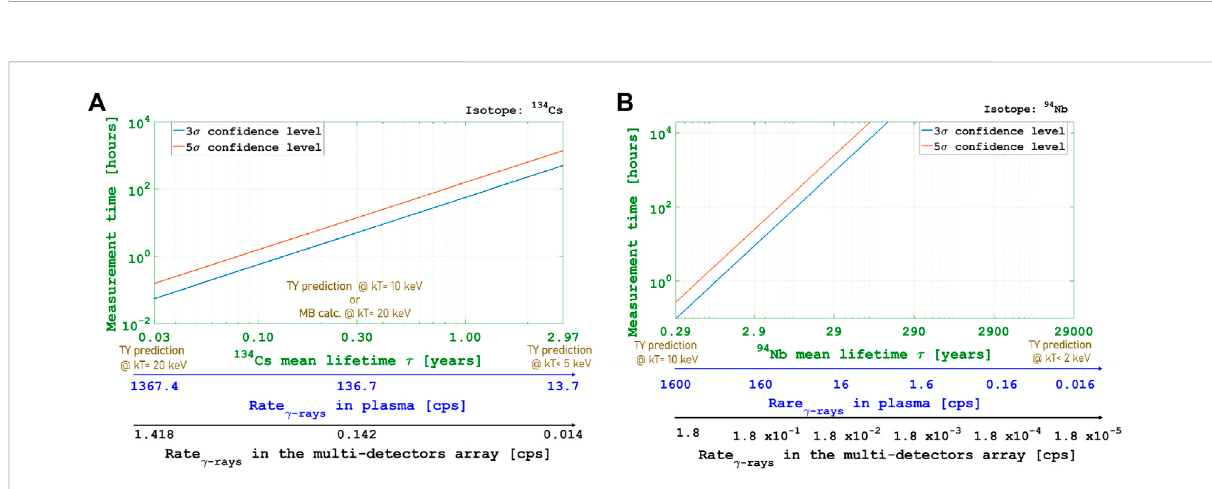
FIGURE 13 “ Iso-signi fi cance ” levelat3 σ and5 σ reachedafteragivenmeasurementtime,reportedonthe y -axis,versusthedecayrate(orthelifetime)ofthe 134 Cs radionuclide (A) and of the 94 Nb (B)